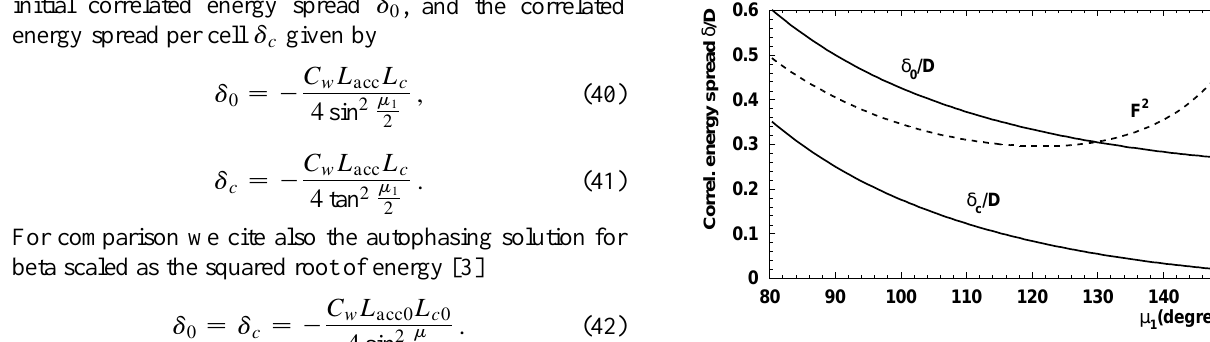
FIG. 3. An autophasing required BNS (cid:115) d (cid:99) (cid:121) (cid:68) (cid:100) and initial (cid:115) d (cid:121) (cid:68) (cid:100) correlated energy spreads (solid lines) versus the phase (cid:48) advance at the first cell m (cid:49) ( (cid:68) (cid:173) (cid:67) (cid:119) (cid:76) (cid:97)(cid:99)(cid:99) (cid:76) (cid:99) ). The dashed line shows the emittance enlargement factor ( F (cid:50) ) for a beam accelerated up to energy g (cid:173) (cid:49)(cid:48) g (cid:48) . The chromaticity is scaled as the square root of g (cid:48) (cid:121) g